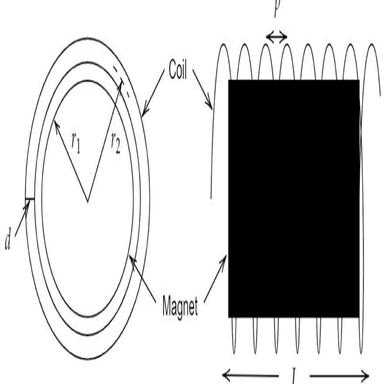
Simplified diagram of the sensor electromagnetic components.